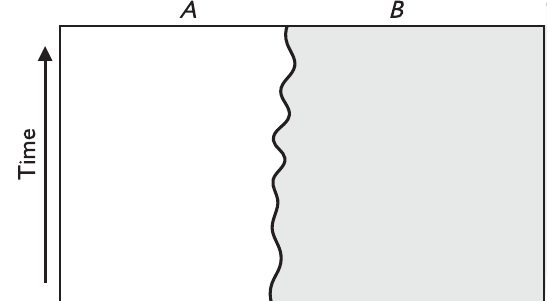
FIG. 17. The average entanglement purity function for a directed random walk. At the top boundary, the walk terminates at the position of the entanglement cut between sub- systems A and B . At the bottom boundary, the end point is